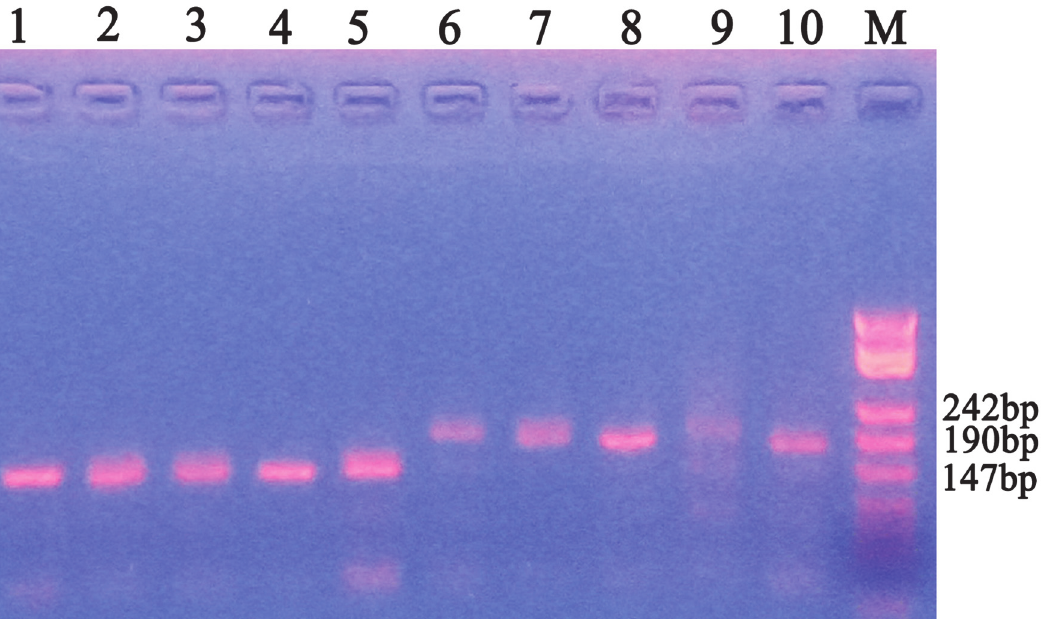
Fig 3. Electrophoresis of the primary and secondary P . vindemmiae females. 1 – 5: Wuhu strain, with about 150 bp fragments on gel electrophoresis, containing (AG) 10 repeats. 6 – 10: Urumqi strain, with about 190 bp fragments, containing (AG) 28 repeats.